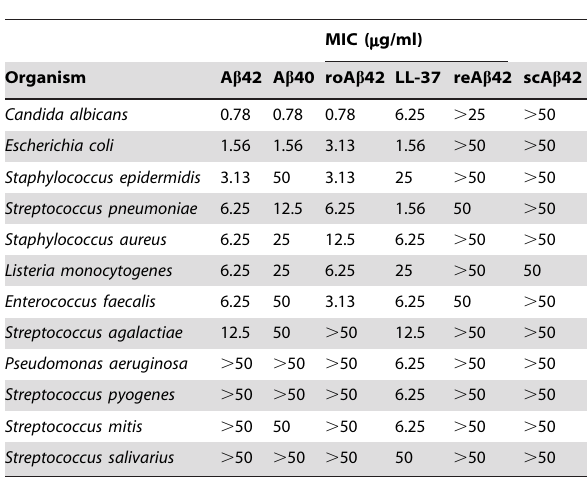
Table 1. A b peptides possess antimicrobial activity.